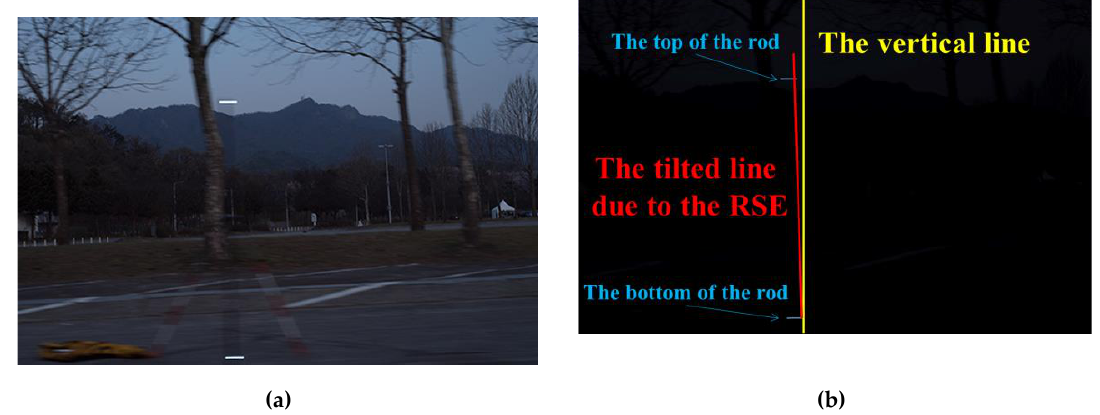
Figure 14. RSE observation: ( a ) brightened image; ( b ) original image with the RSE observation.